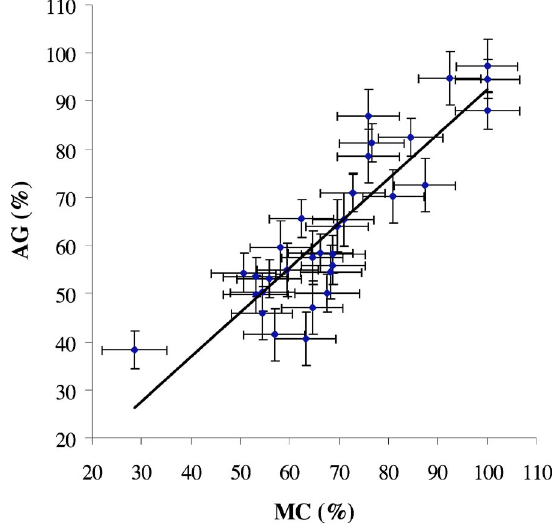
FIG. 6. (cid:1) Color (cid:2) The raw data from the students involved in the validity study (cid:1) N =33 (cid:2) . The graph is a plot of the students’ average- grader score (cid:1) AG (cid:2) versus their multiple-choice score (cid:1) MC (cid:2) .